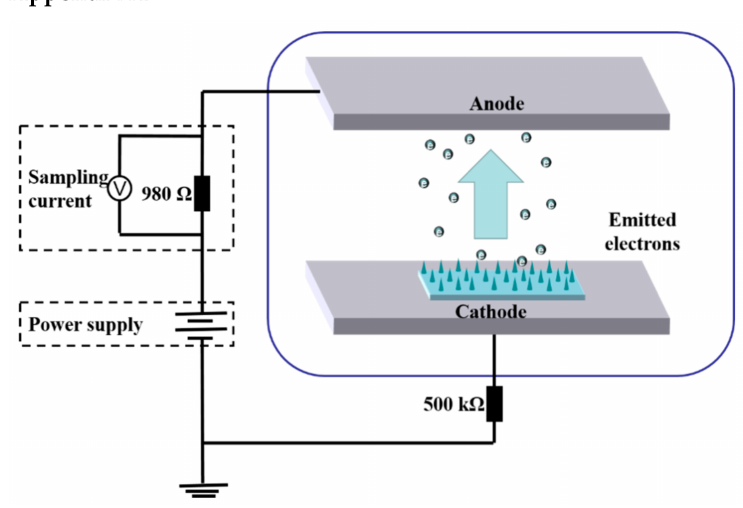
Figure A1. Schematic diagram of field-emission measurement.